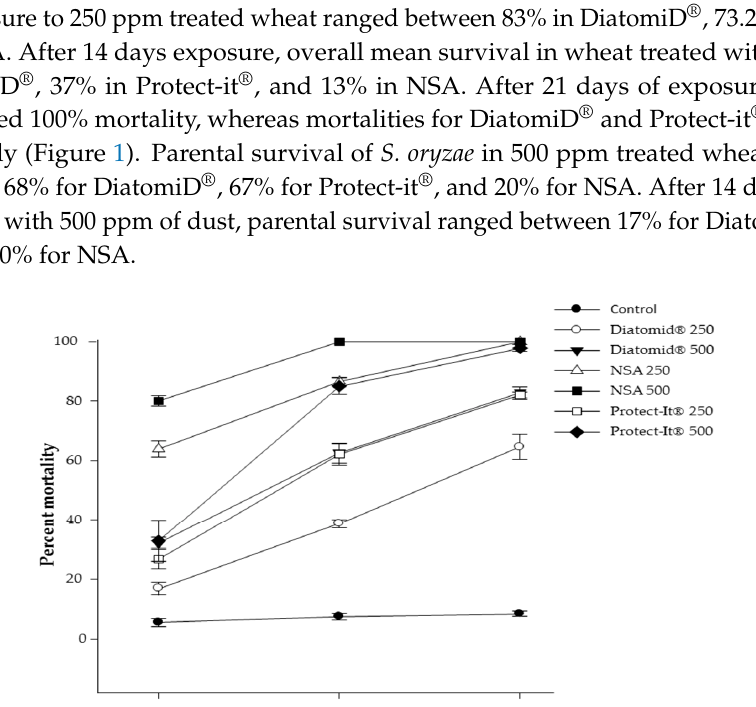
Table 2. Mean wheat weight loss, frass production, and number of adult of Sitophilus oryzae in F1 after 21 days of parental generation exposure and 42 days of development at 27 ± 1 °C and 75% relative humidity (RH). MR is the obtained multiplication rate. Treatment (ppm)